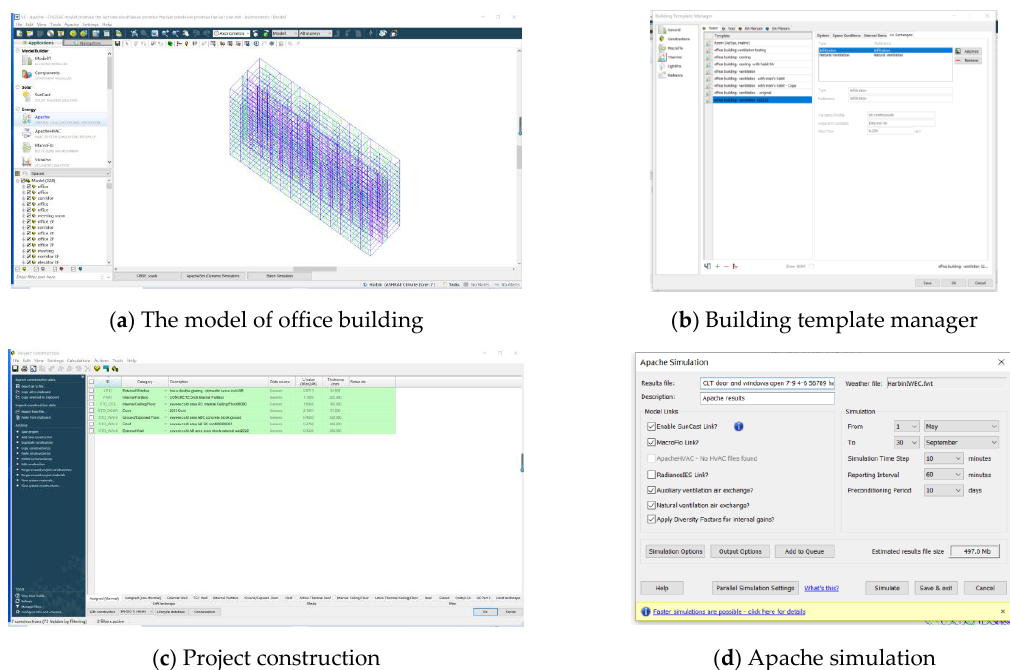
Figure 6. IESVE software operation interface.